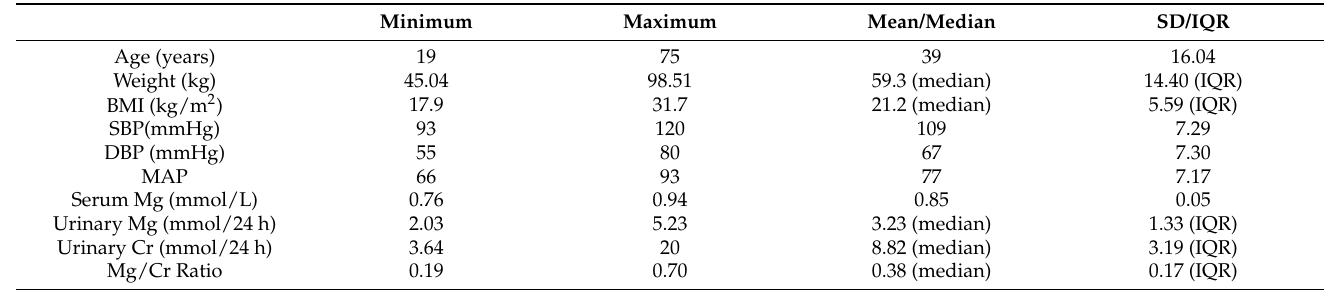
Table 1. Baseline characteristics.